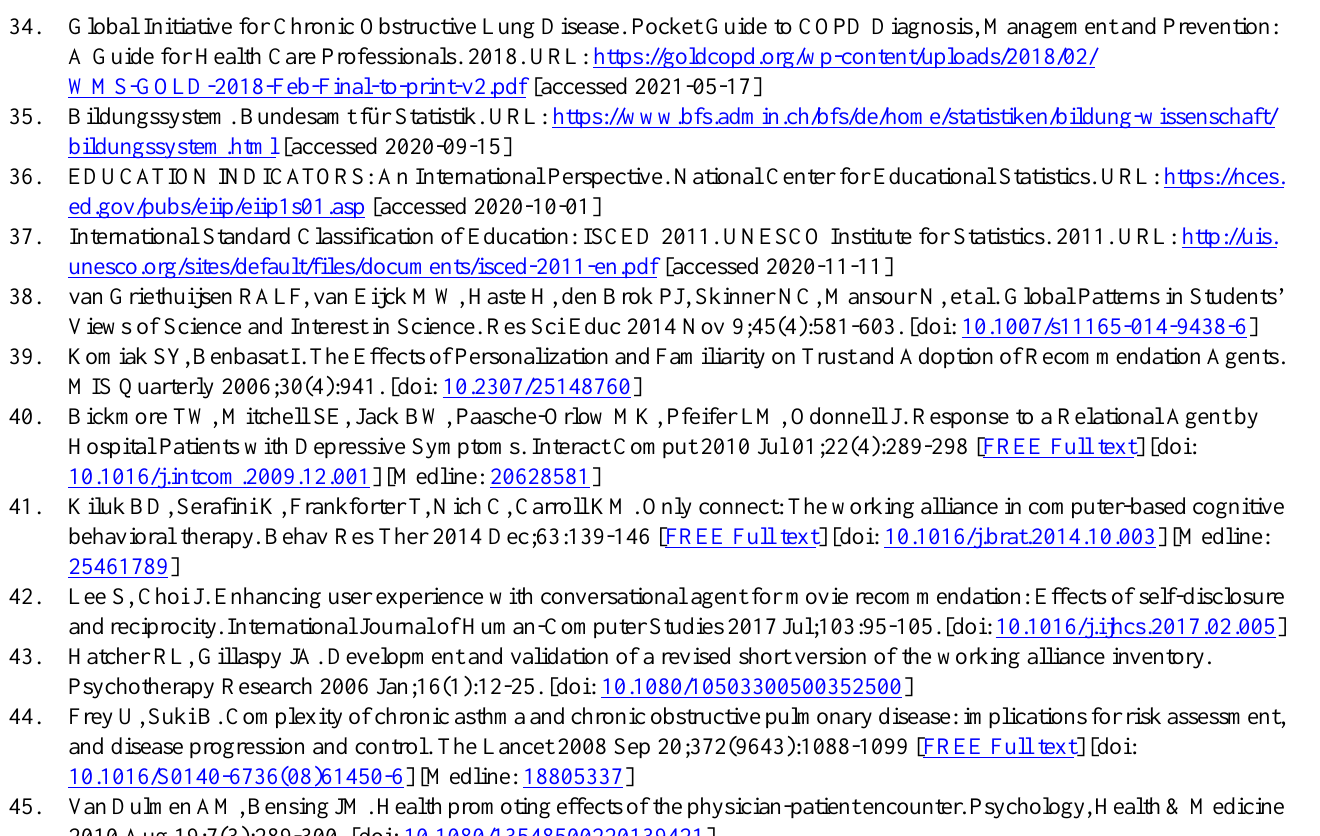
Abbreviations AI: artificial intelligence BCKQ: Bristol COPD Knowledge Questionnaire CA: conversational agent COPD: chronic obstructive pulmonary disease GOLD: Global Initiative for Chronic Obstructive Lung Disease